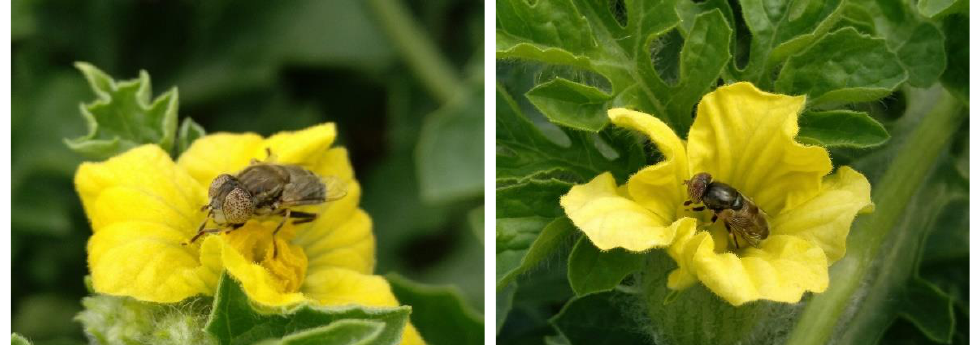
Figure 3. Floral visit of a female of E. aeneus on a pistillate watermelon flower (left), and floral visit of a male of E. aeneus on a staminate watermelon flower (right).